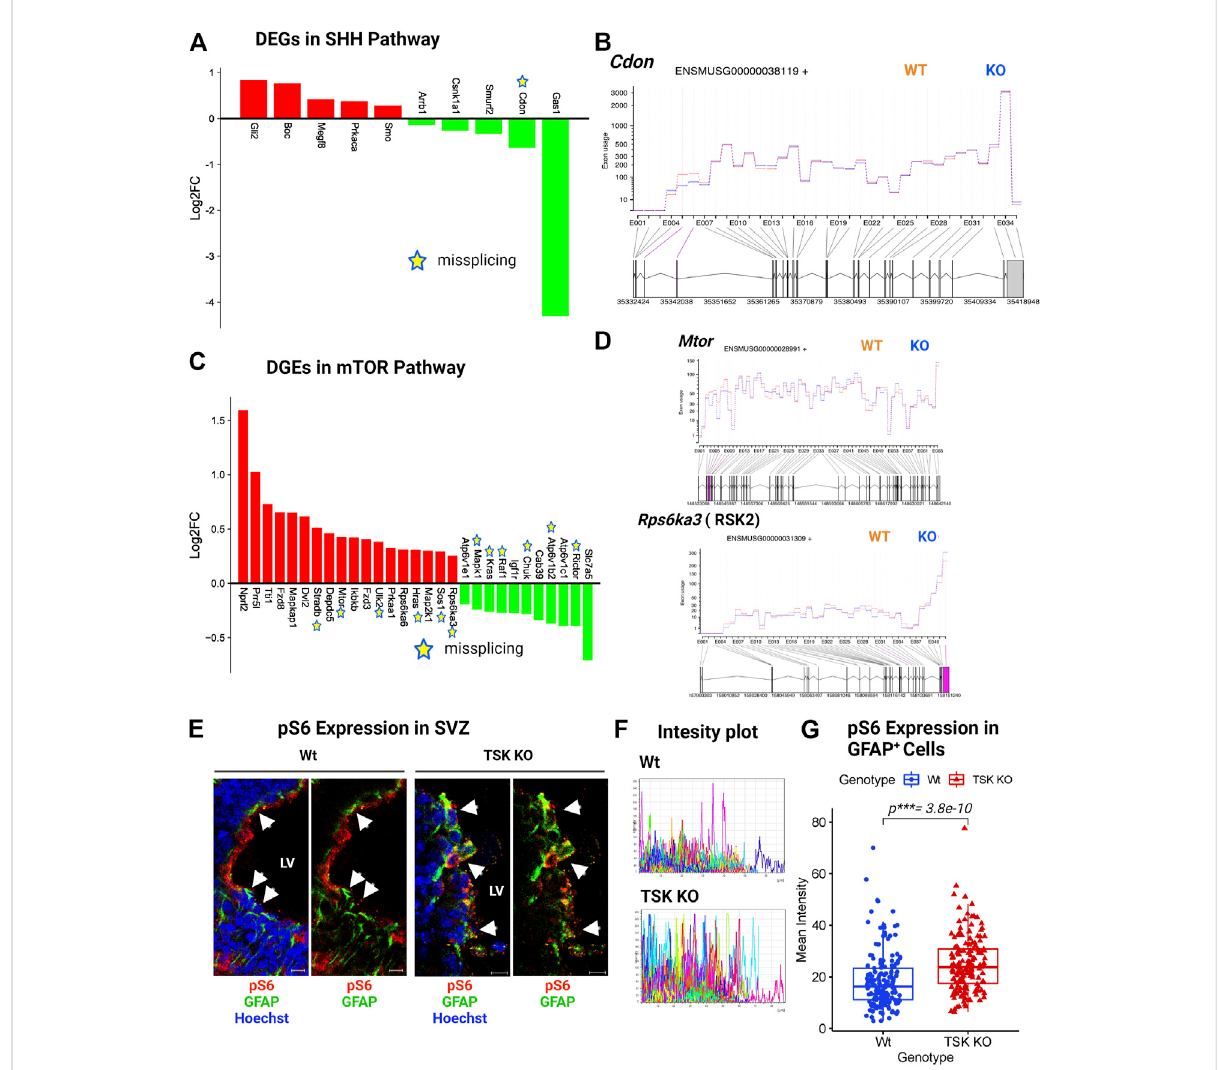
FIGURE 9 TSK regulates the ciliogenesis-associated SHH and mTOR signaling. (A) Expression of SHH pathway-associated DEGs. Red and green bars indicategeneswithincreasedanddecreasedexpression,respectively (B) FittedsplicingplotforDEUinrepresentativeSHHpathway-associatedgene Cdon .Pinkindicatestheexonwithsigni fi cantdifferentialexonusage. (C) ExpressionofDEGsassociatedwiththemTORpathway.Redandgreenbars indicate genes with increased and decreased expression, respectively. Expression bars are annotated similar to those in (A). (D) Fitted splicing plot for DEU in representative mTOR pathway-associated crucial gene Mtor and Rps6ka3 . Plot is annotated similar to that in (B). (E) Representing images of P3 stage TSK KO SVZ immunostained for GFAP (Green), pS6 (Red) and Nuclei (Hoechst, blue). Arrowheads indicates pS6 expression in GFAP + cells. Scale bar = 10 μ m. (F) Representative fl uorescent (Alexa fl our 647) intensity plot for pS6 expression in GFAP + cells of a single SVZ. Colored curves represent individualcells. The peakheightofthecurvere fl ects theintensity value,while thecurvelength re fl ectsthemeasuredarea. (G) Mean intensity distribution of pS6 expression in GFAP + cells SVZ. Distribution is shown by box plot with jitters. Each dot represents an individual cell. Number of brain samples: nTSK KO = 3, nWt =